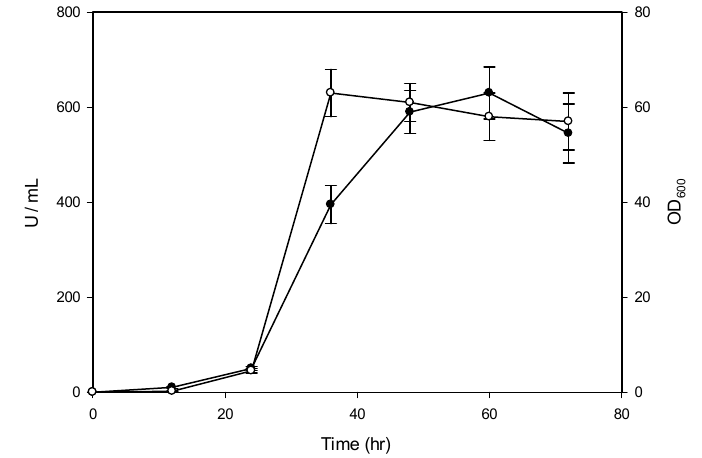
Figure 2. Time course of β -glucosidase activity in a Y. lipolytica transformant (pYLSC1- bgl ). (- ● -) extracellular β -glucosidase activity; (- ○ -), OD 600 nm. The culture conditions were: temperature 28 °C; shaking speed 200 rpm.